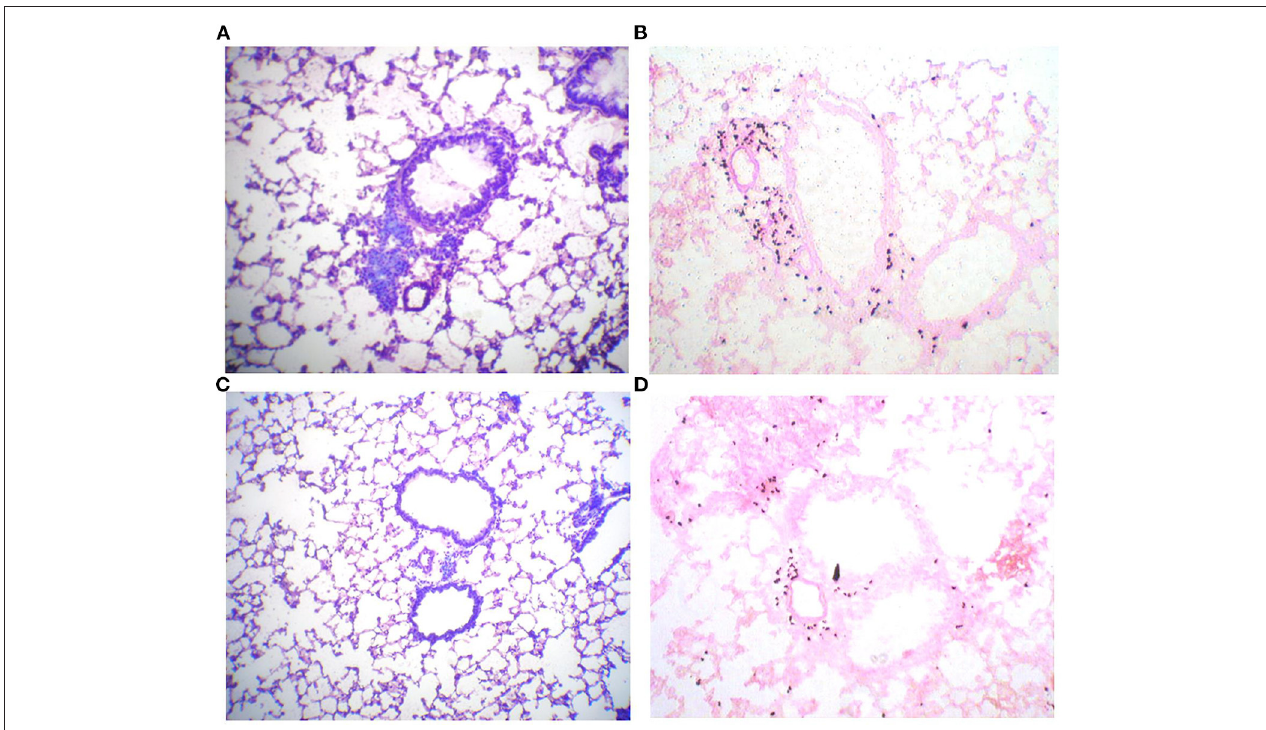
FIGURE 2 | Phl p5b-induced leucocytic infiltrates of lung tissue are reduced by SCIT. Lung histology: 10 µ m lung slices of a sham-treated mouse (A,B) and a mouse treated four times with immunotherapy (C,D) . (A) Pappenheim staining shows the accumulation of lymphocytes around broncheolus and pulmonal arteriola. (B) Staining of eosinophilic peroxidase with Diaminobenzidin/H 2 O 2 reveals that these infiltrations mainly consist of eosinophils. (C) Pappenheim staining of a lung slice of a mouse treated with immunotherapy reveals reduced infiltration of leucocytes. (D) Infiltration of eosinophils is also decreased in this